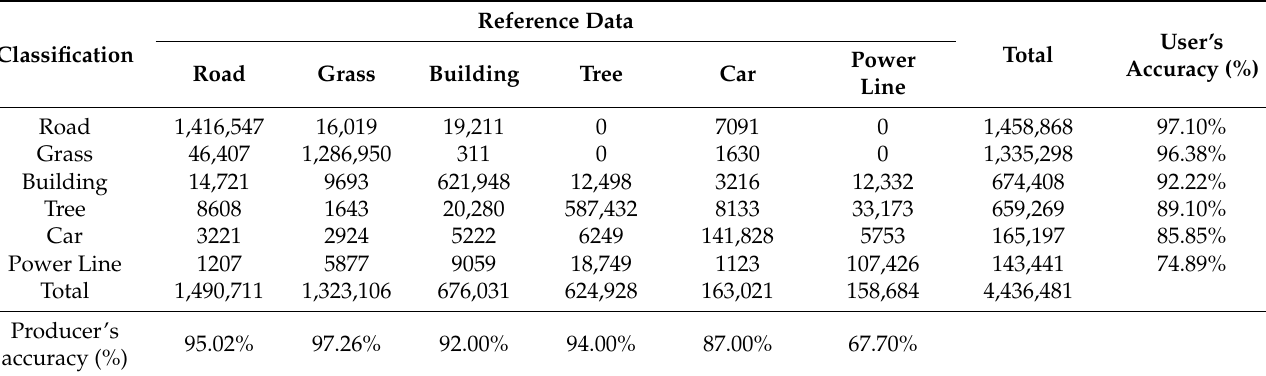
Table 7. Point cloud classification confusion matrix for method